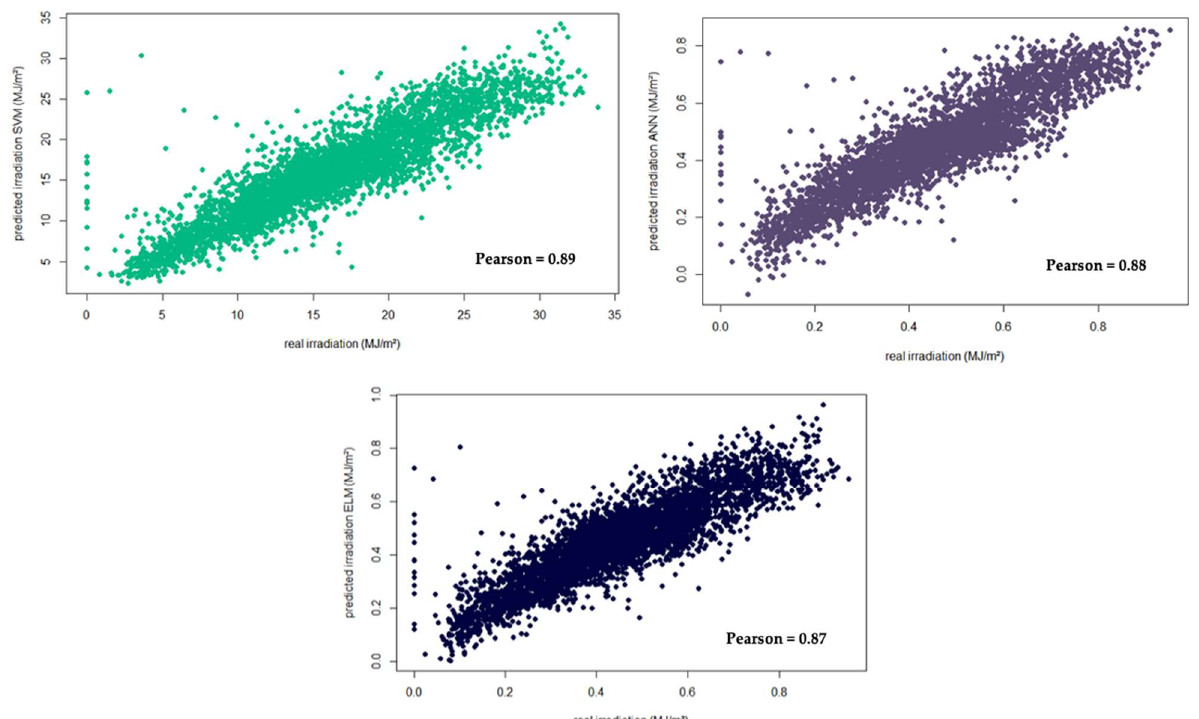
Figure 5. Predicted irradiation versus real measured irradiation when all the meteorological parameters were applied to the models. SVM ( upper right ), ANN ( upper left ) and ELM ( lower center ).